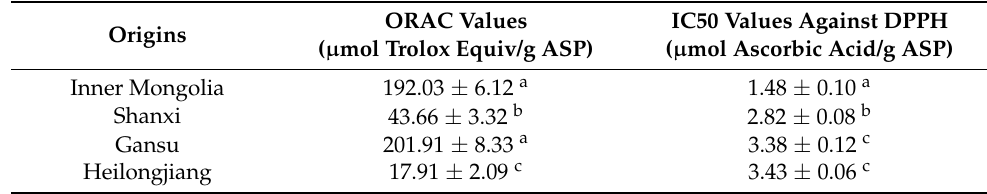
Table 3. Antioxidant activity of APS from four